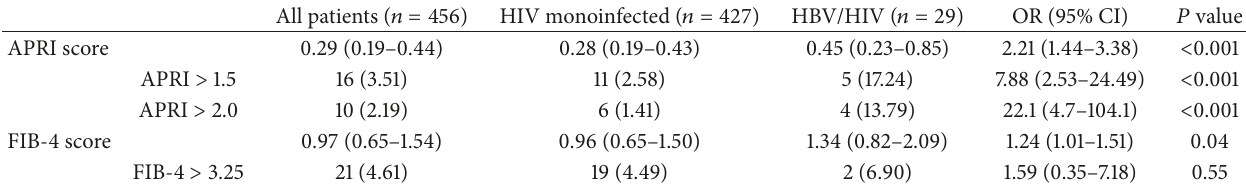
Table 3: Prevalence of liver fibrosis by APRI and FIB-4 scores among HIV monoinfected and HIV/HBV coinfected